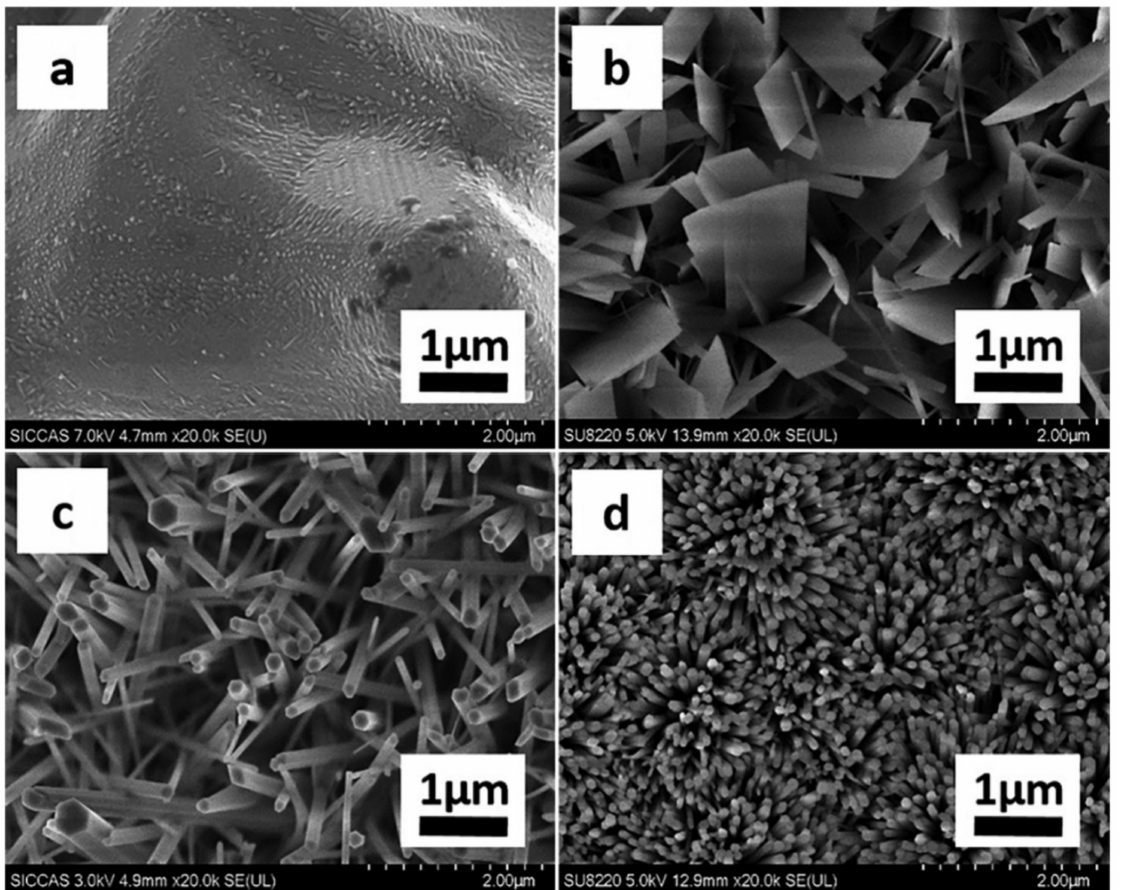
Figure 6. Scanning electron microscope (SEM) images of HA coated scaffolds prepared in an initial solution with dif- ferent pH values at 120 ◦ C for 12 h: ( a ) A Fe scaffold without HA coating and ( b − d ) HA coating generated at pH 6, 9, and 13, respectively. Reproduced from [58], with permission of American Chemical Society 2018. Abbreviation: HA,